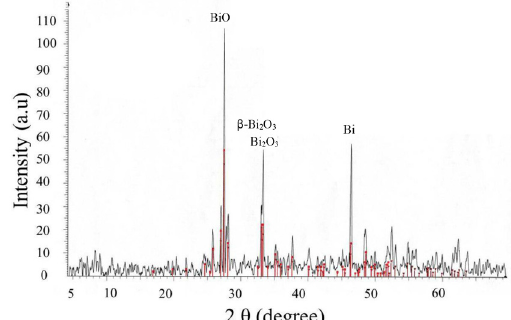
Fig. 3. Characterization of X-ray crystallography (XRD) of Bi